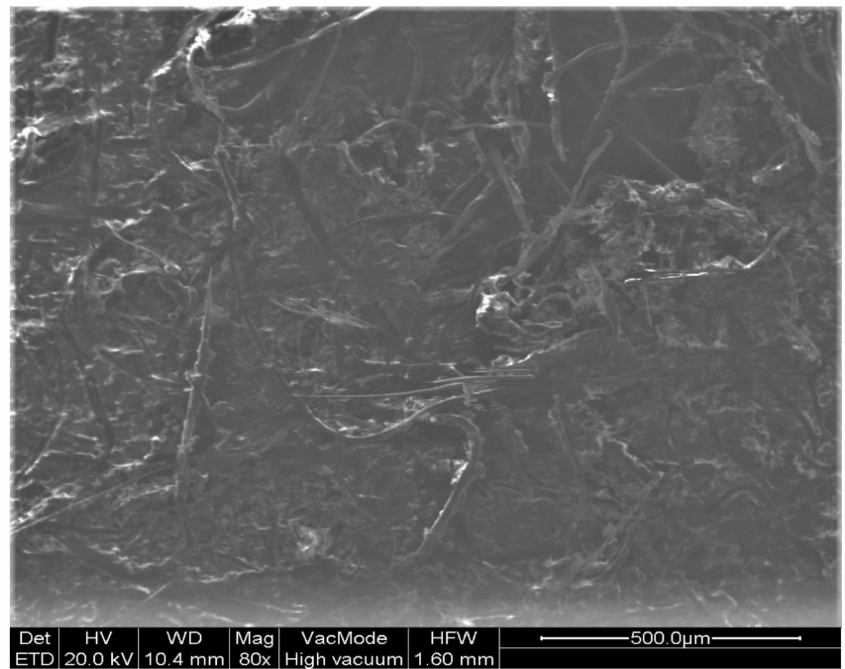
Figure 3. Scanning Electron Microscopy picture of the surface of the deposition (SEI 80 × ) (School of Dentistry, National and Kapodistrian University of